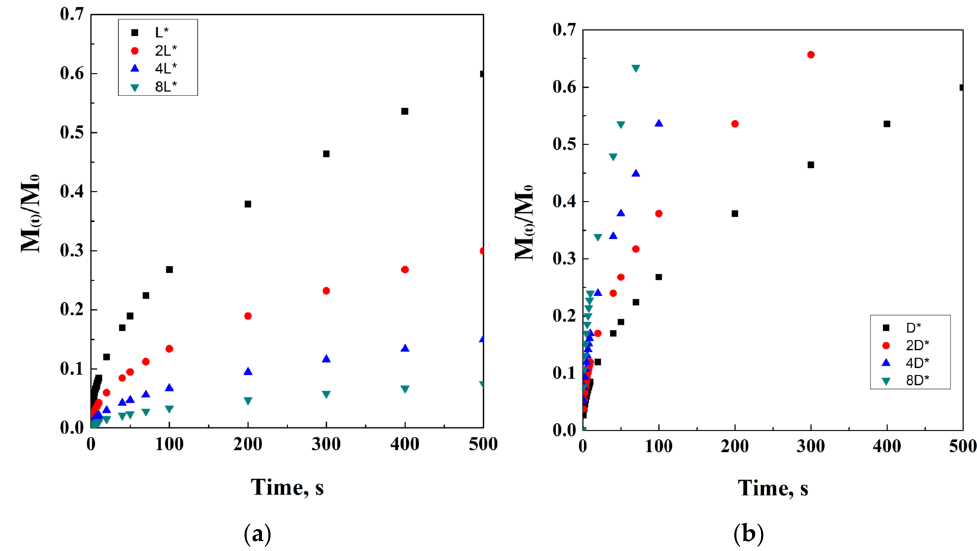
Figure 2. Crank and Baker model at different thickness values ( a ) and diffusion coefficients ( b ).